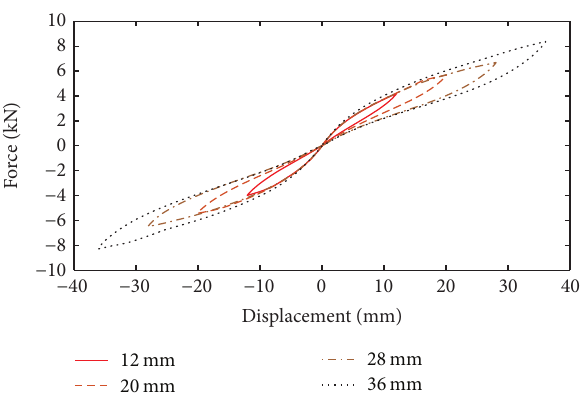
Figure 5: Hysteresis loops at different displacement